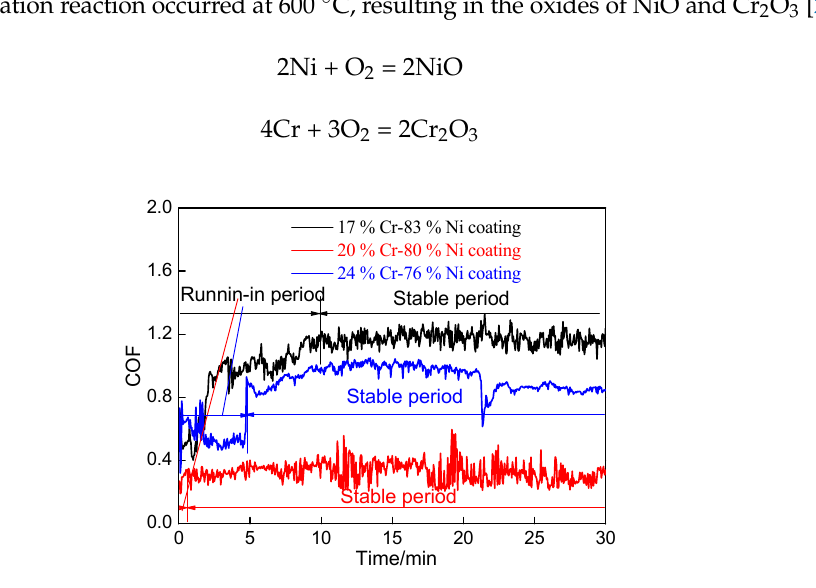
Figure 11. COFs of Cr–Ni coatings vs wear time.